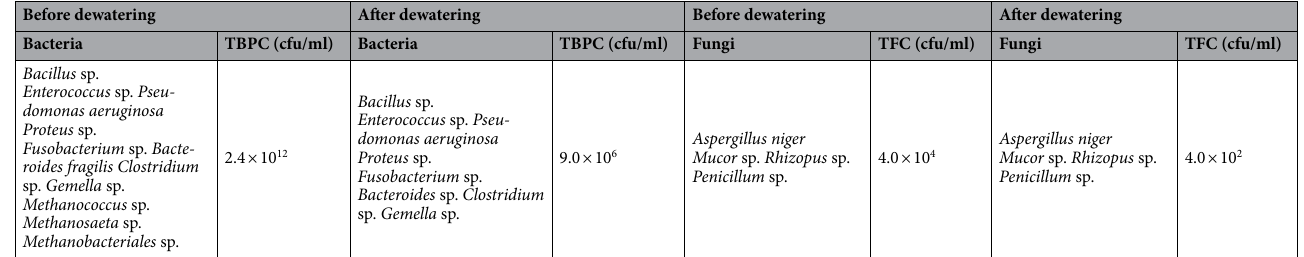
Table 5. Microbial composition of Carica papaya fruit peel organic fertilizer. Values shown in table are means of triplicate analyses; TBPC total bacterial plate count, TFC total fungal